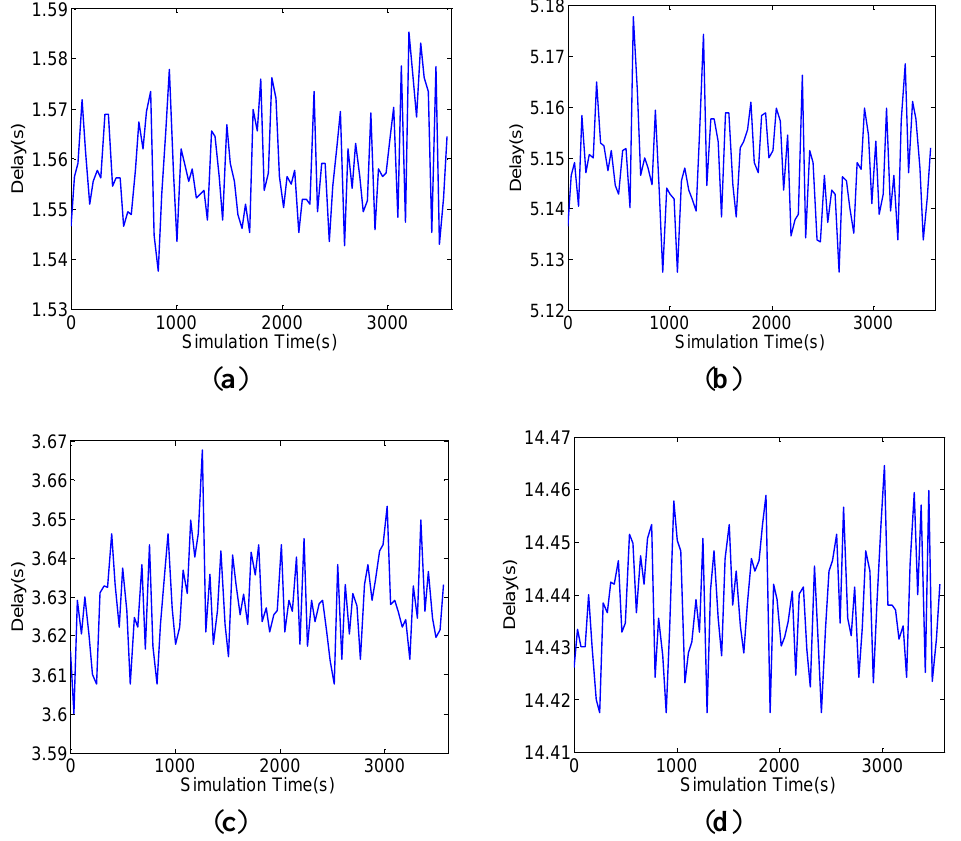
Figure 13. Simulation results of delay. ( a ) Simulation results of t t ’ ; ( c ) Simulation results of T d 3